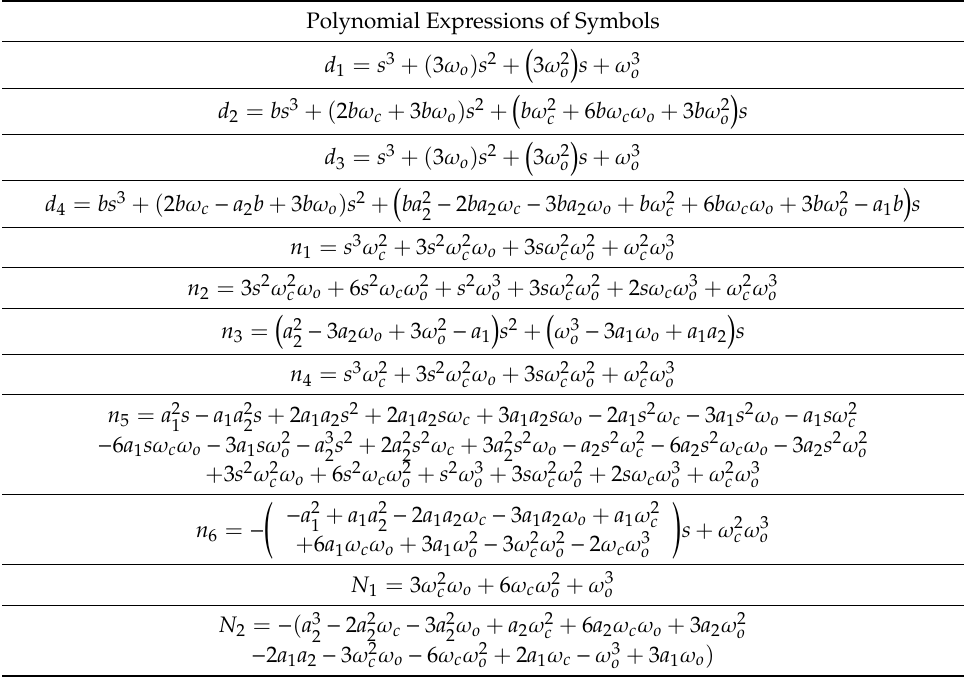
Table A1. Polynomials in transfer functions G r ( s ) and G y ( s